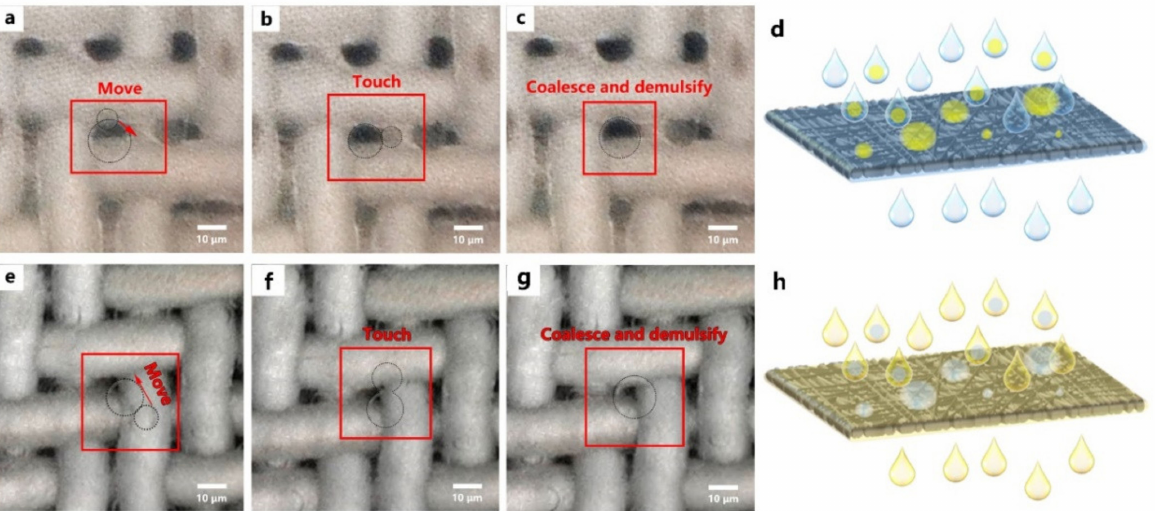
Figure 10. Mechanism of demulsification process of oil-in-water and water-in-oil emulsions; ( a – c ) coalescence and demulsification of emulsified oil droplets; ( e – g ) coalescence and demulsi- fication of emulsified water droplets; ( d , h ) suppositional separation process of oil-in-water and water-in-oil